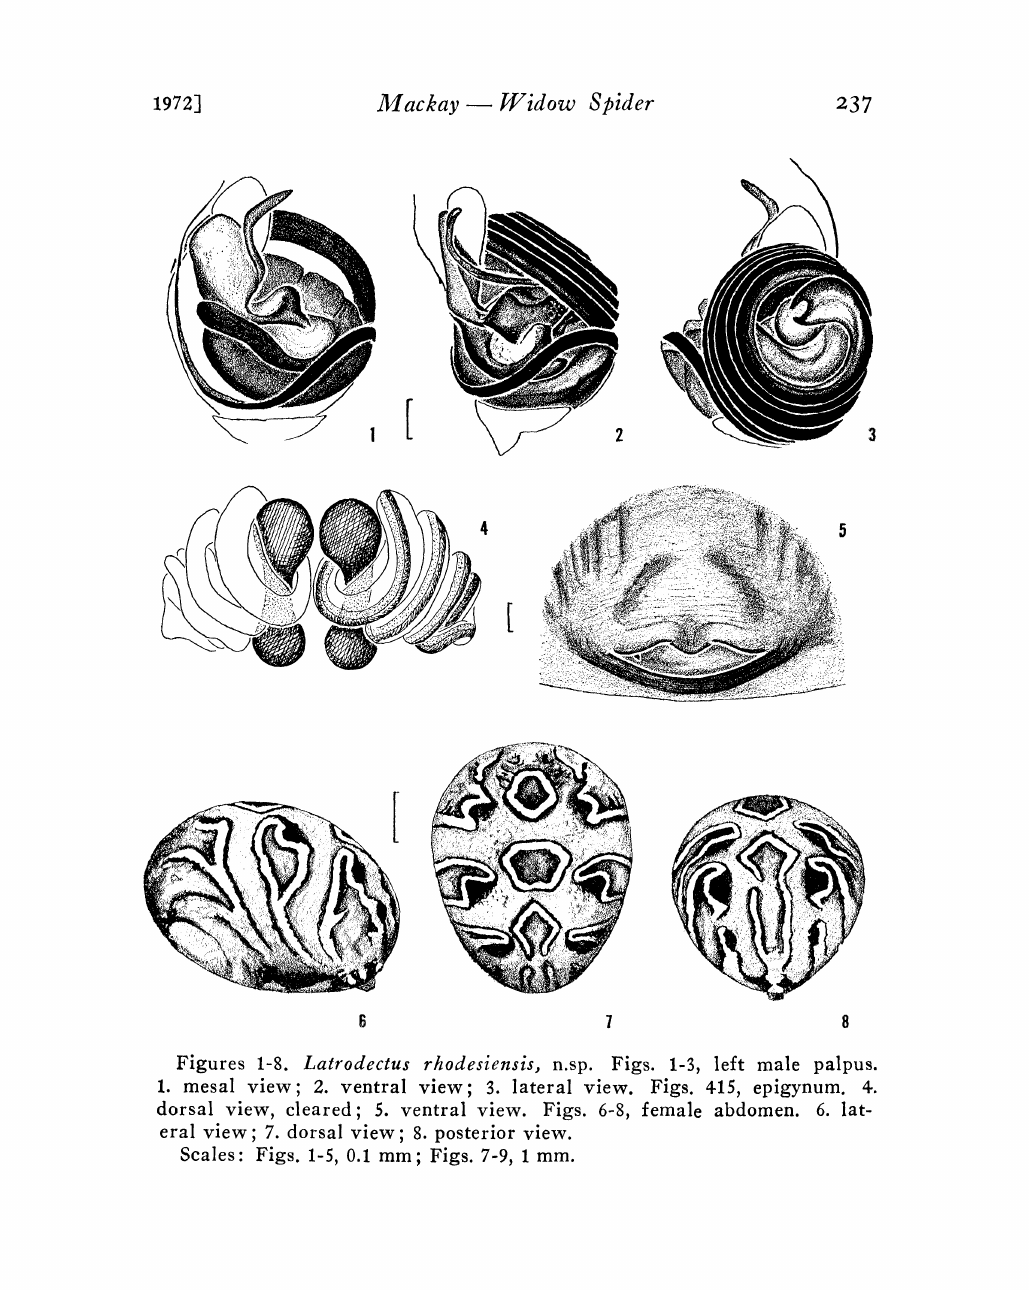
Figures 1-8. Latrodectus rhodesiensis, n.sp. Figs. 1-3, left male palpus. 1. mesal view; 2. ventral view; 3. lateral view. Figs. 415, epigynum. 4. dorsal view, cleared; 5. ventral view. Figs. 6-8, female abdomen. 6. lat- eral view; 7. dorsal view; 8. posterior view. Scales: Figs. 1-5, 0.1 ram; Figs. 7-9,